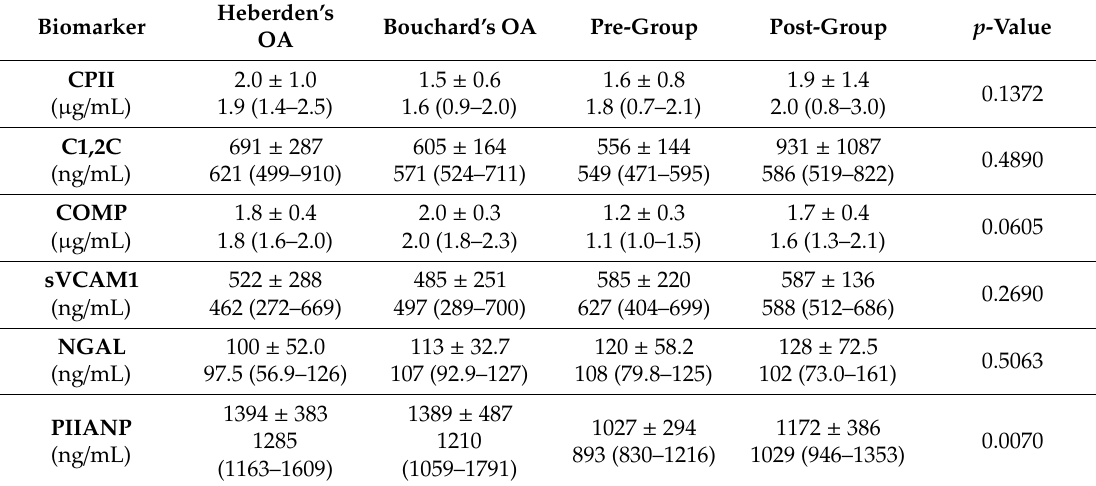
(Figure 3: CPII; Figure 4: COMP; Figure S1–S3: NGAL, C1,2C, and sVCAM1). Table 2. Baseline biomarker Table 2. Baseline biomarker levels.